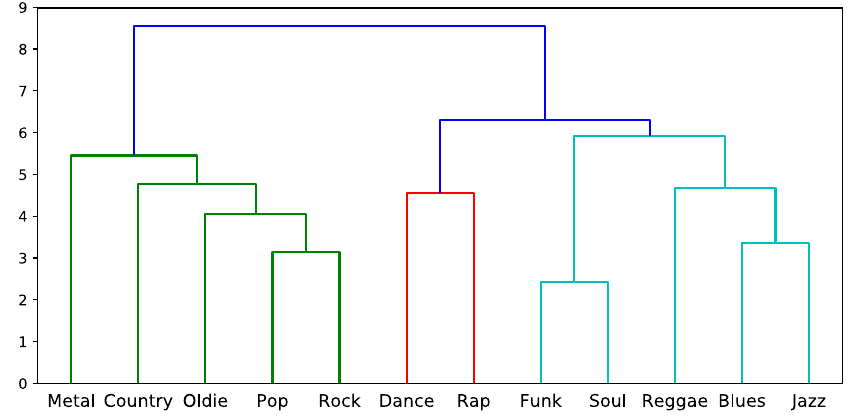
Figure 5. Dendrogram for Joint importance profiles across STOMP music preferences.